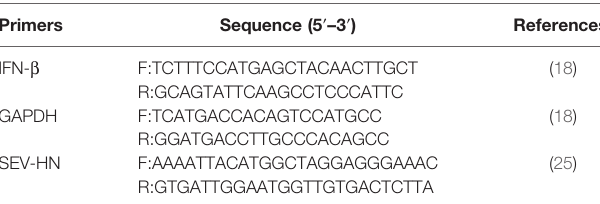
TABLE 1 | Primers used for real-time